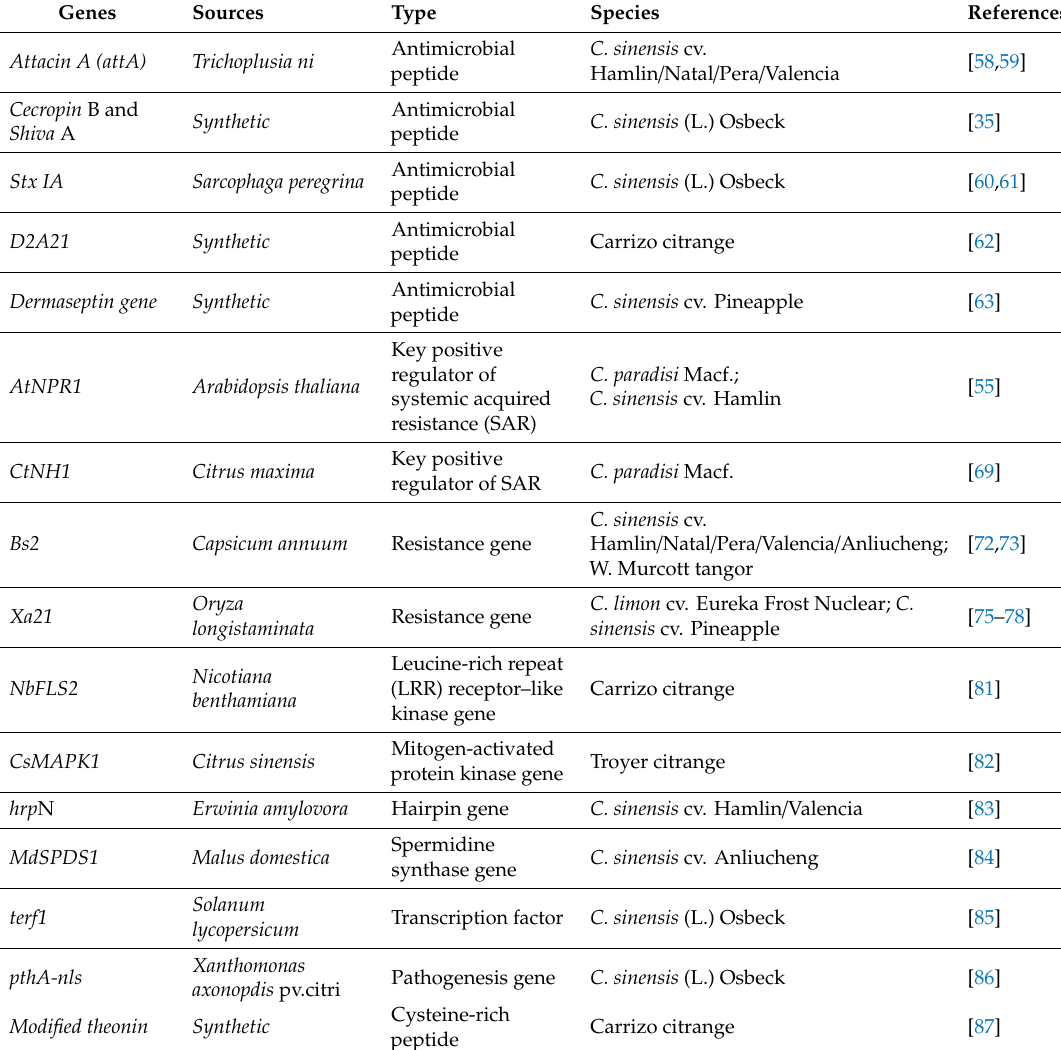
Table 1. The genes used in the genetic transformation of citrus to impart resistance to